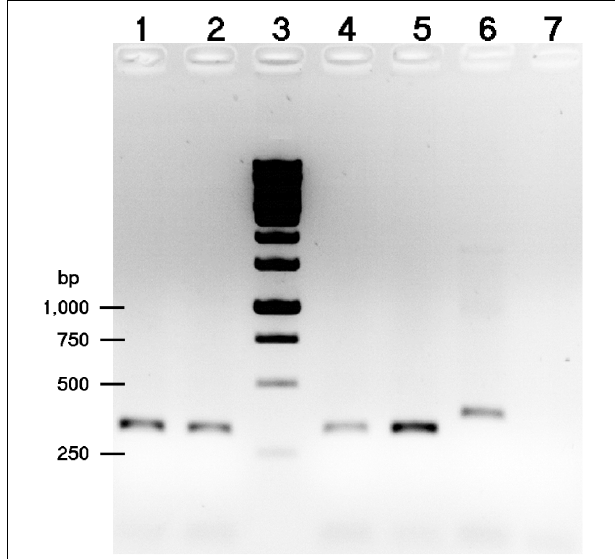
FIGURE 3 | Separation of 23S-For1+ITS-Rev2 PCR amplified products on 1% agarose gel. The templates used were as follows: lanes 1, 2, and 4, gDNA from bacteria isolated from different nodules of G. soja CH2 inoculated with NGR234; lane 5, NGR234 gDNA; lane 6, HH103 Rif R gDNA; lane 7, no DNA. Lane 3, DNA molecular weight marker (bands corresponding to 1,000, 750, 500, and 250-bp are indicated on the